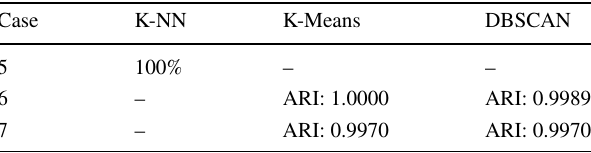
Table 10 Results for rig operation classification, where ARI